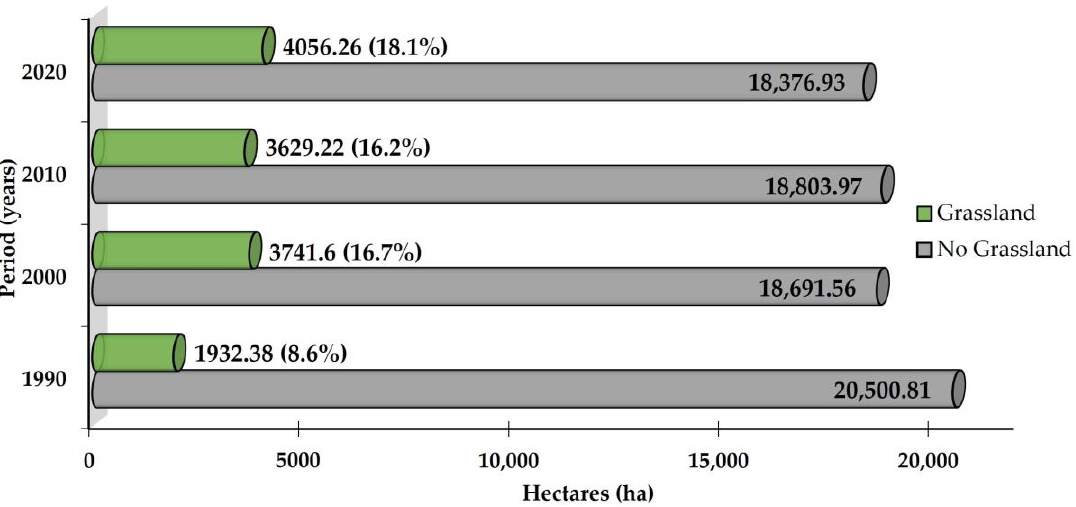
The spatiotemporal dynamics of the grassland and no-grassland classes for the Ventilla micro-basin showed similar patterns to those of the Pomacochas micro-watershed (Figure 7). In the last two years of evaluation, the grassland increased in its extension, reducing the class of no-grassland that could be deduced in the vegetation cover to agricultural uses or increases in the urban area.